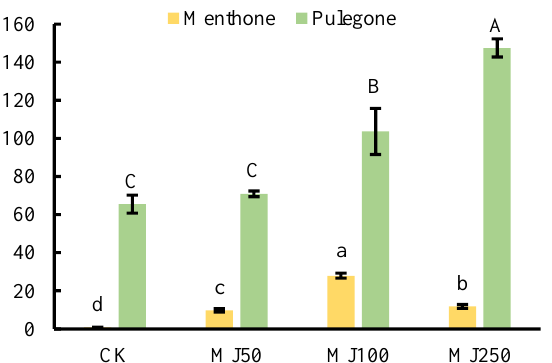
Figure 1. Variation of monoterpenoid content in Schizonepeta tenuifolia at different MeJA Levels. The uppercase letters and lowercase letters, respectively, represent the significant difference ( p < 0.05) between the treatment groups of pulegone and menthone. CK 0 μM; MJ50 50 μM; MJ100 100 μM; MJ250 250 μM.